Question: According to the figure, is the described quantity increasing or decreasing?
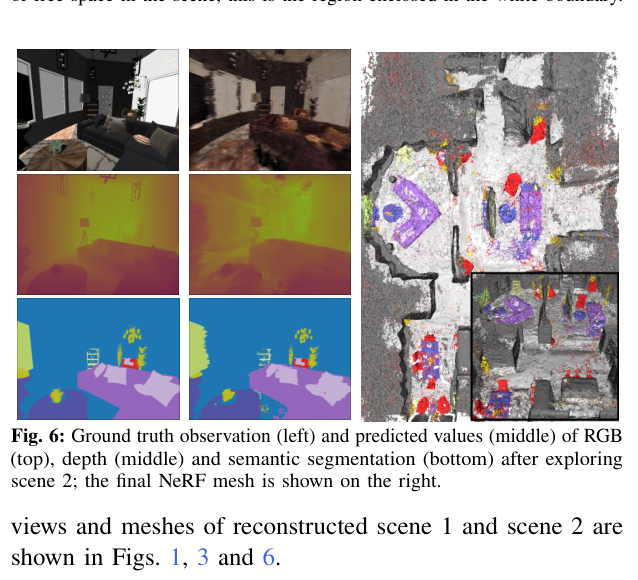
Answer: increasing